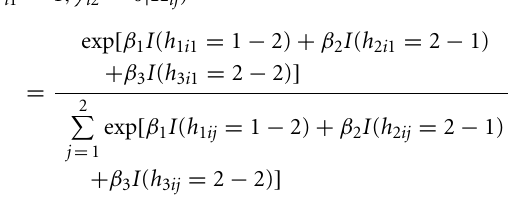
the haplotypes spanned by the markers have OR > 1 (i.e., all β = 0; denoted as null model) and assessed the FPR of the combined haplotype-specific association test. The intercept value of α was chosen to yield the disease rates of different disease models (i.e., null, mild, and moderate effect models) approximately at